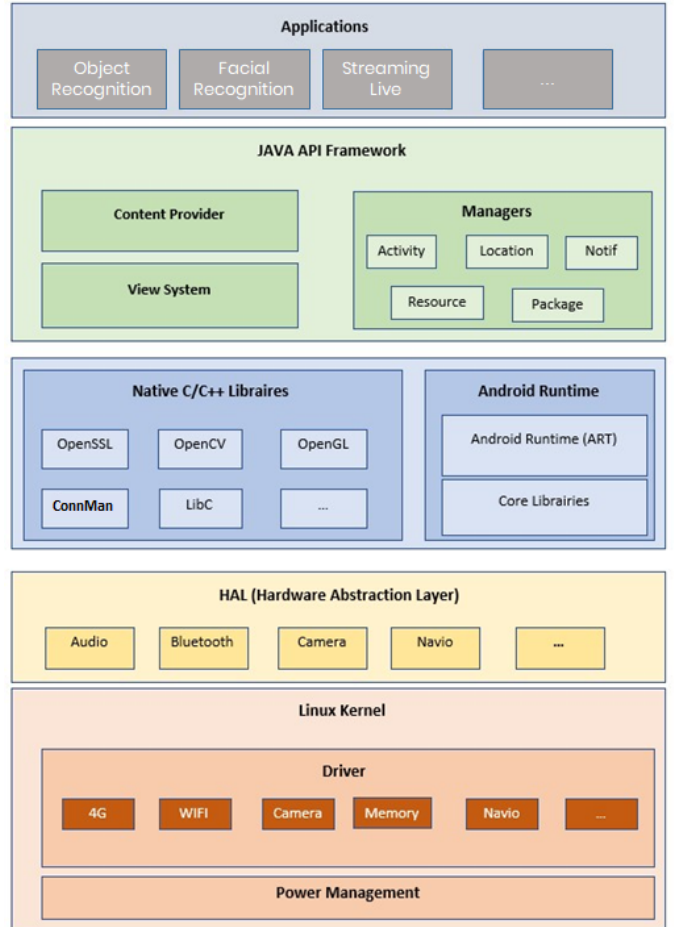
Figure 3. The software architecture of